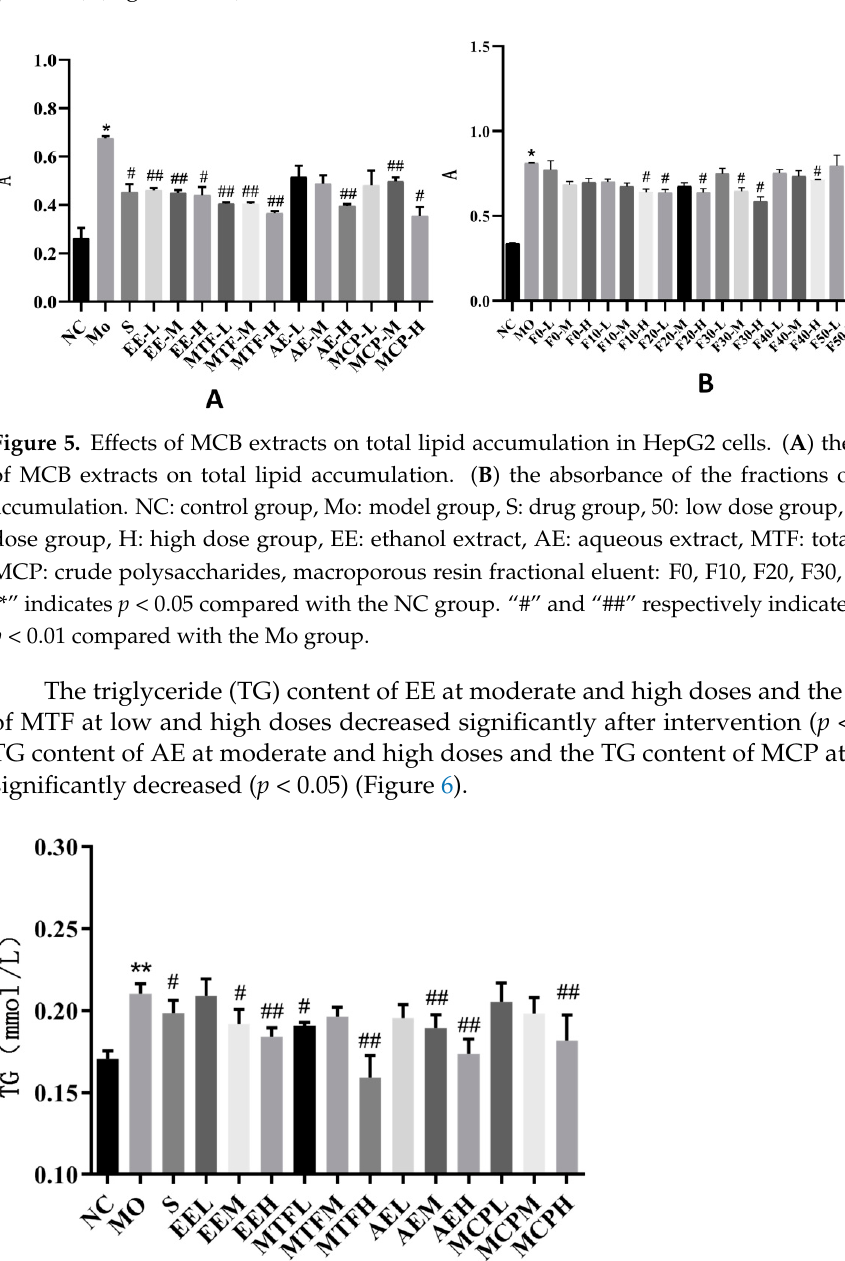
Figure 6. Effects of MCB extracts on TG level in HepG2 cells. NC: control group, Mo: model group, S: drug group; 50: low dose group, M: moderate dose group, H: high dose group, EE: ethanol extract, AE: aqueous extract, MTF: total flavonoids, MCP: crude polysaccharides. “**” indicates p < 0.01 compared with the NC group. “#” and “##” respectively indicate p < 0.05 and p < 0.01 compared with the Mo group.